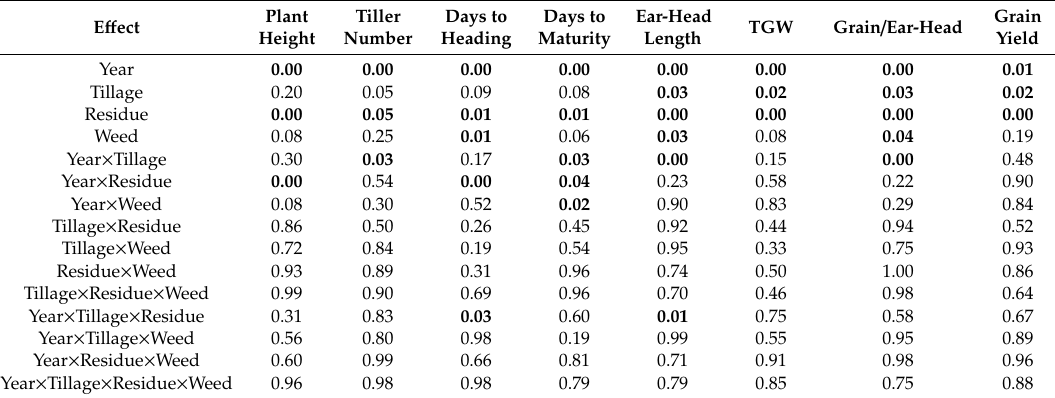
Table 1. Significance ( P -values) of the e ff ects of year, tillage, residue and weed managements and their interactions on yield and yield attributes of rice. The P -values are presented with bold fonts if analysis of variance showed significance di ff erence ( P < 0.05). TGW: 1000 grain weight. E ff ect